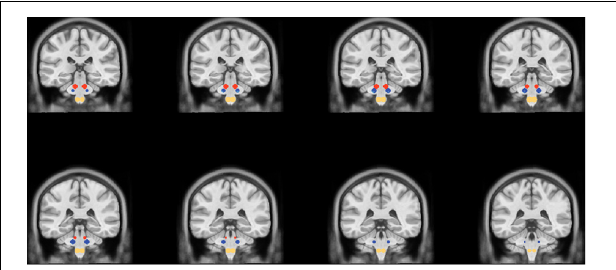
FIGURE 1 | Coronal slices showing the location of the spherical regions of interest for the DM (red circles), the Vp (blue circles), and the Sp (yellow